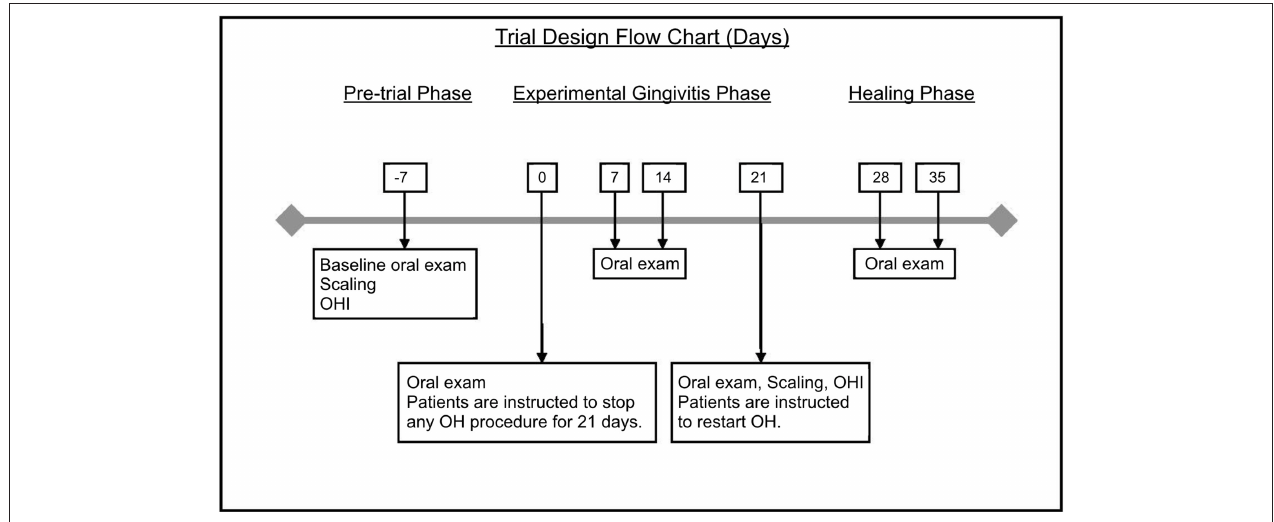
FIGURE 1 | Experimental gingivitis trial design flow chart (days). Stimulated whole saliva samples were collected at each time